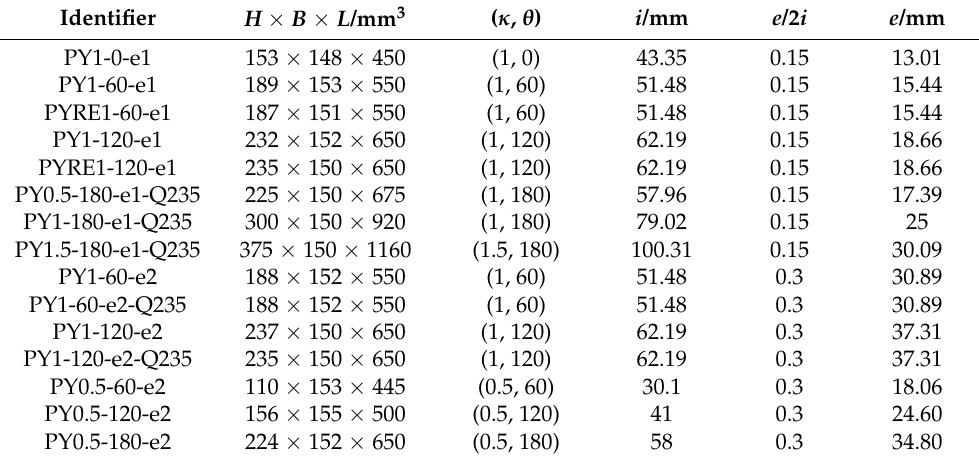
Table 1. Main parameters of